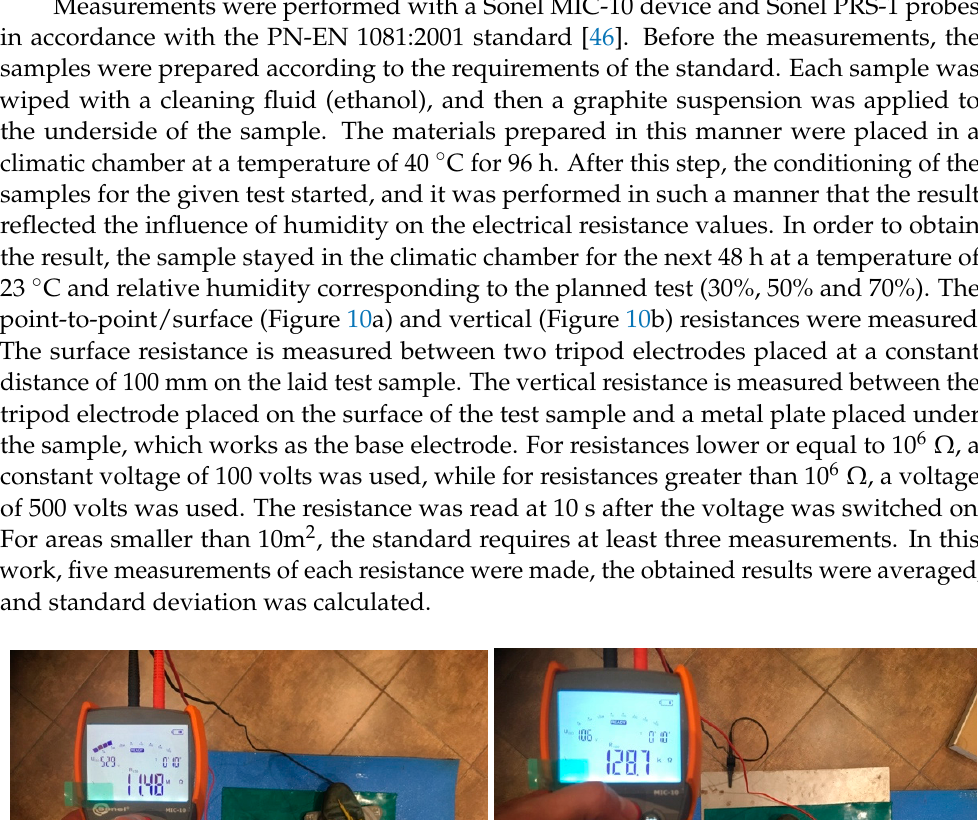
Figure 11 . Tensile testing machine